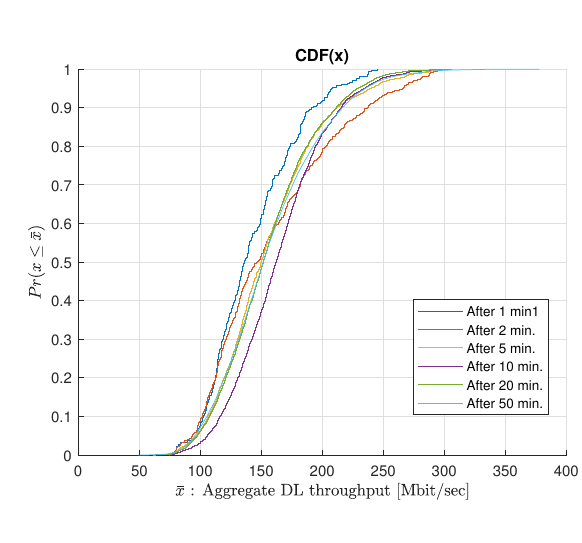
Figure 2. CDF of aggregated DL throughput.